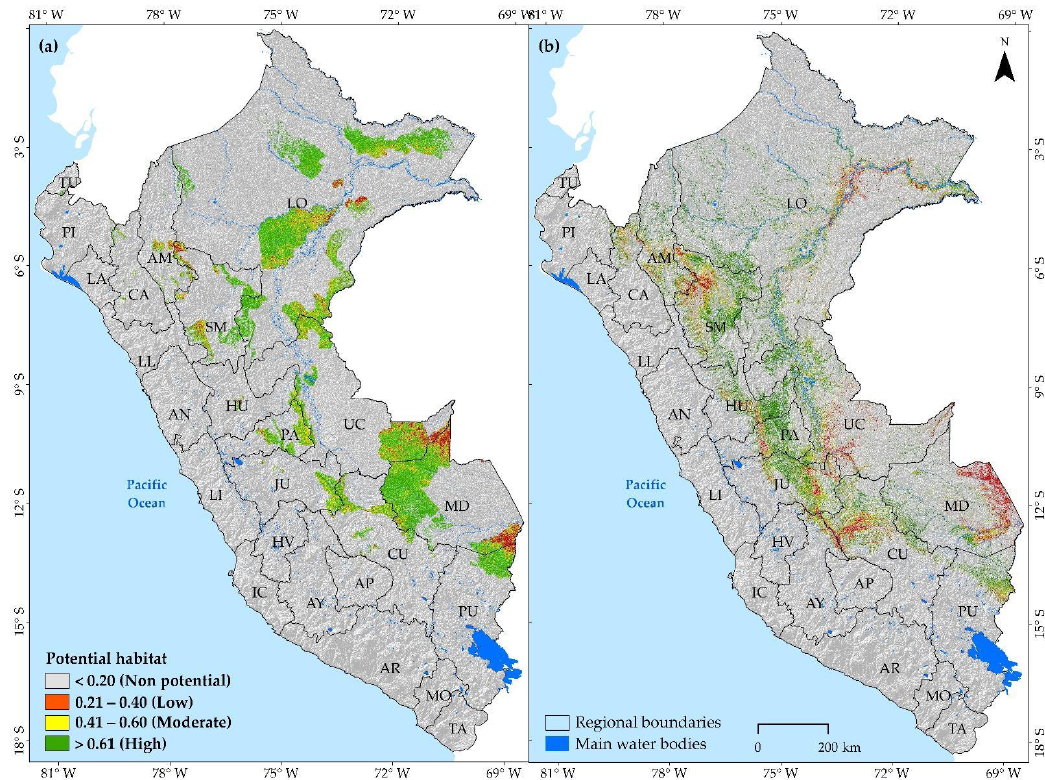
Figure 5. Priority areas ( a ) for research and conservation practices, and ( b ) for the restoration of degraded Peruvian areas with genus Cedrela .